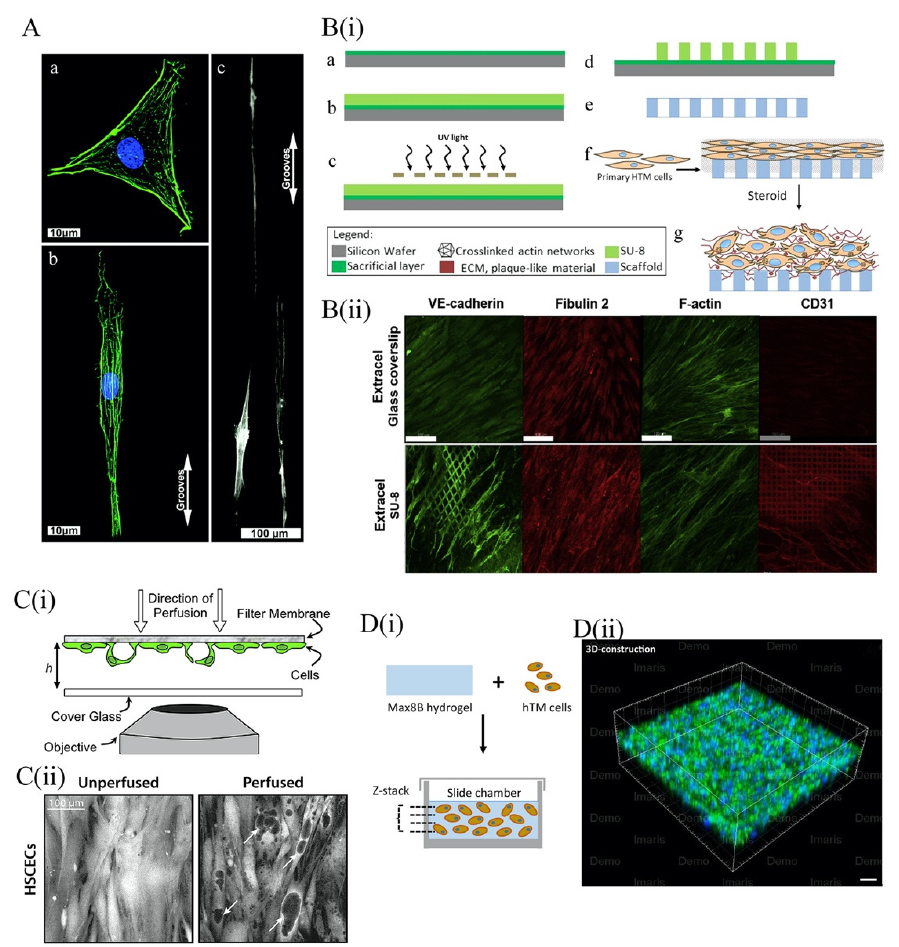
Figure 4. 2D and 3D models of trabecular meshwork and Schlemm’s canal. ( A ) Comparison of TM cells on planar surface ( a ) and groove-patterned nano-surface ( b , c ). The actin filaments (green) were randomly oriented on planar surface but aligned on patterned surface. Blue: nuclei [112]; ( B ) TM and SC models based on porous SU-8 scaffolds; ( i ) fabrication of SU-8 scaffolds; ( a ) pre-cleaned silica wafer treated with a sacrificial layer; ( b ) photoresist SU-8 2010 coating; ( c ) UV-exposure using chrome mask; ( d ) post-exposure bake; ( e ) development to produce SU-8 freestanding scaffold; ( f ) HTM cell seeding on the SU-8 scaffold followed by 3D-culture; ( g ) steroid-treatment to generate glaucomatous 3D HTM model [114]; ( ii ) comparison of human Schlemm’s canal endothelial cells on glass coverslip and SU-8 porous scaffold. F-actin staining showed better fiber alignment on SU-8 sca ff old. Expression cell characteristic marker CD31, which is lost in 2D-culture, was also recovered on SU-8 sca ff old. Other characteristic markers—VE-cadherin and fibulin-2—were maintained. Scale bar is 100 µ m [92]; ( C ) human Schlemm’s canal endothelial cells were cultured on Transwell; ( i ) diagram of the perfusion system; ( ii ) giant vacuole-like structures (arrows) observed with perfusion [115]; ( D ) ( i ) combining TM cells with Max8B hydrogel to reconstruct 3D environment; ( ii ) 3D-reconstruction of TM cells in MAX8B sca ff old; green: F-actin; blue: nuclei red [116]. Figure republished with permission from each indicated reference ([112] for part A, [92,114] for part B, [115] for part C, [116] for part